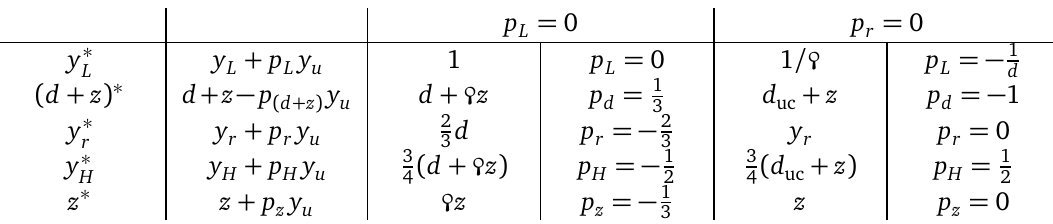
Table 1: Modified scaling powers for the (LR)TFIM when choosing p respectively. The choice p system size invariant, while the choice p istic length scale invariant.